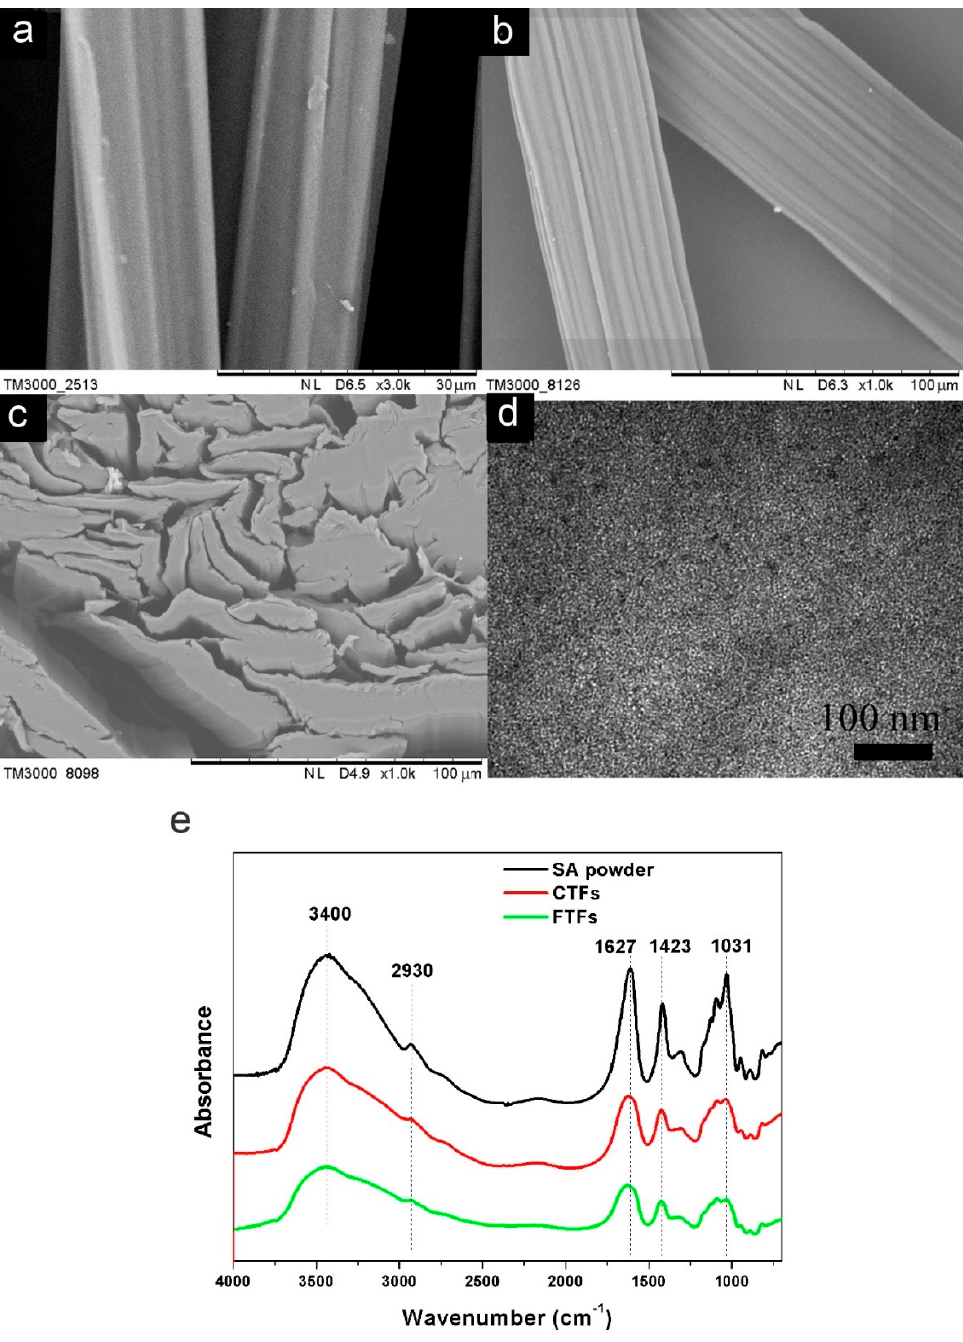
Figure 2. Plane view SEM images of ( a ) Calcium alginate textile fibres (CTFs) and ( b ) fluorescent textile fibres (FTFs), ( c ) cross-section SEM image of FTFs, ( d ) TEM image of FTFs and ( e ) FT-IR spectra of sodium alginate (SA) power, CTFs and FTFs.